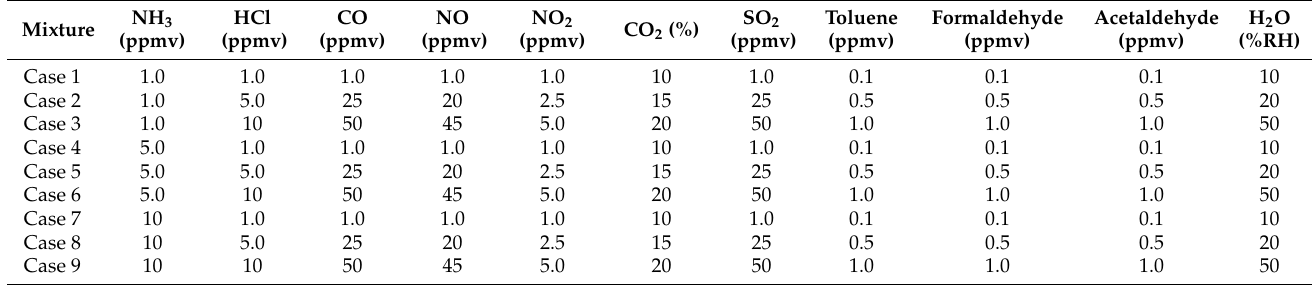
Table 2. Various concentrations of mixture gases used for investigating interference effect on NH 3 measurement. Mixture